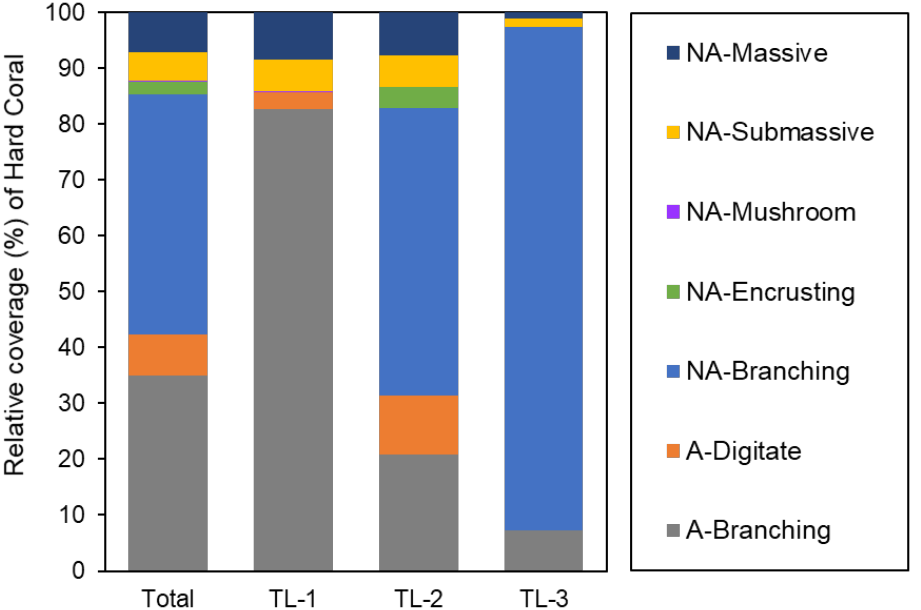
Figure 4. Relative coverage of hard coral morphotype along each transect line (TL). NA: Non- Acropora species; A: Acropora species.